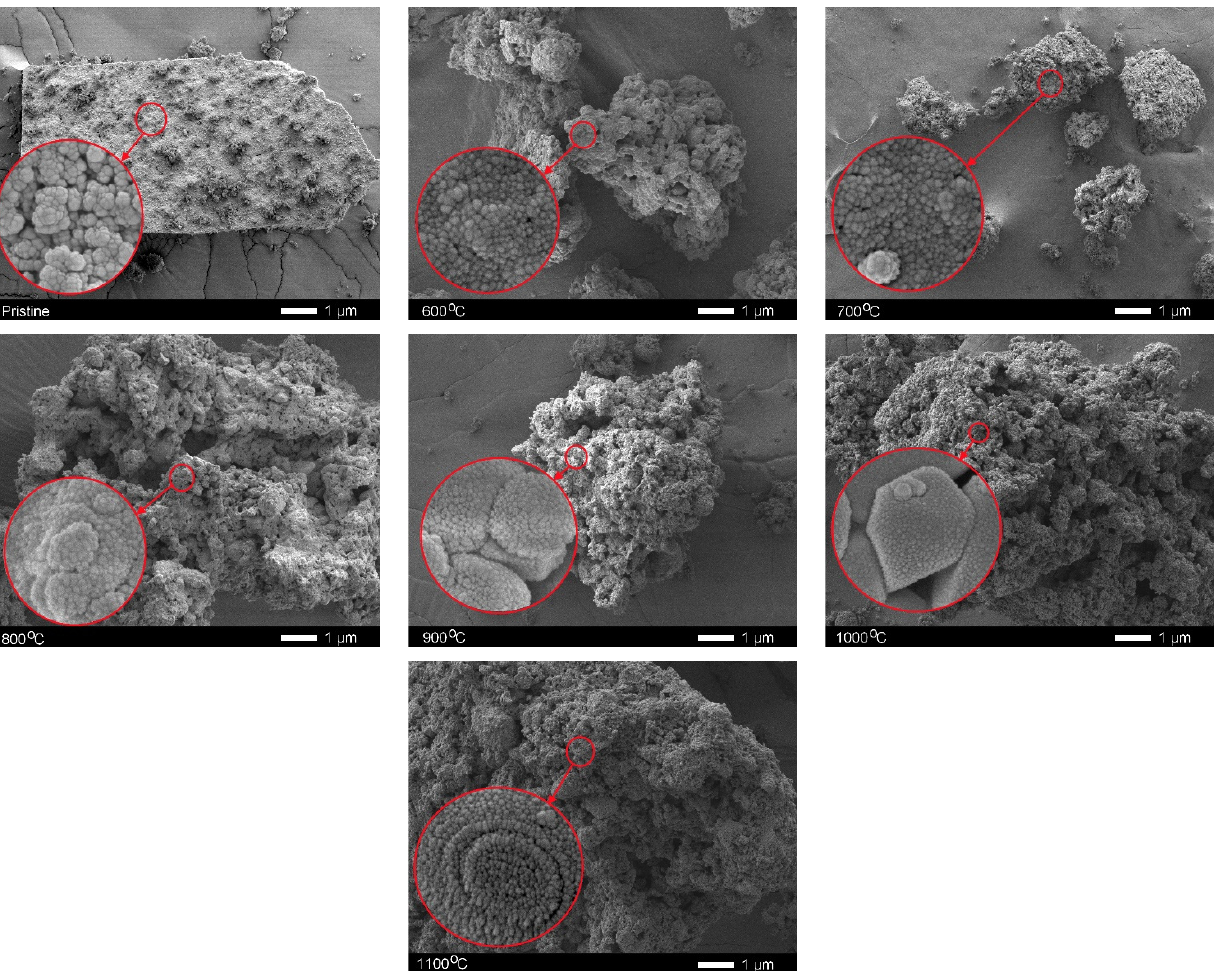
Figure 1. SEM images of synthesized ceramics depending on the annealing